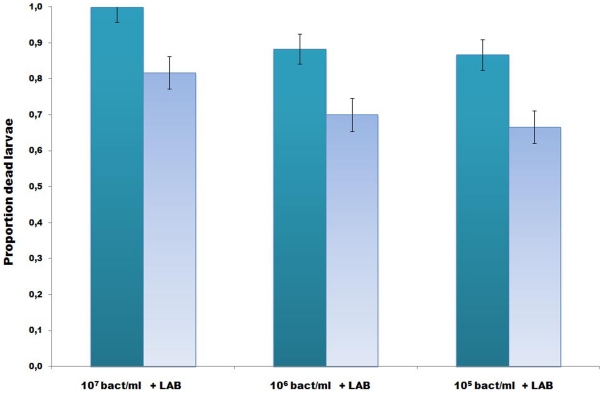
LAB rescue of honeybee larvae from European Foulbrood.Proportion dead larvae in both replicates (total number dead after 21 days). Data presented as a mean for the three groups fed M. plutonius (107, 106 and105 bacteria ml−1), and the 3 groups fed M. plutonius and LAB. Irrespective of infectious dose, the overall effect from the LAB supplement was a significantly reduced mortality in the treated groups. Mortality in the uninfected control groups was <7%.